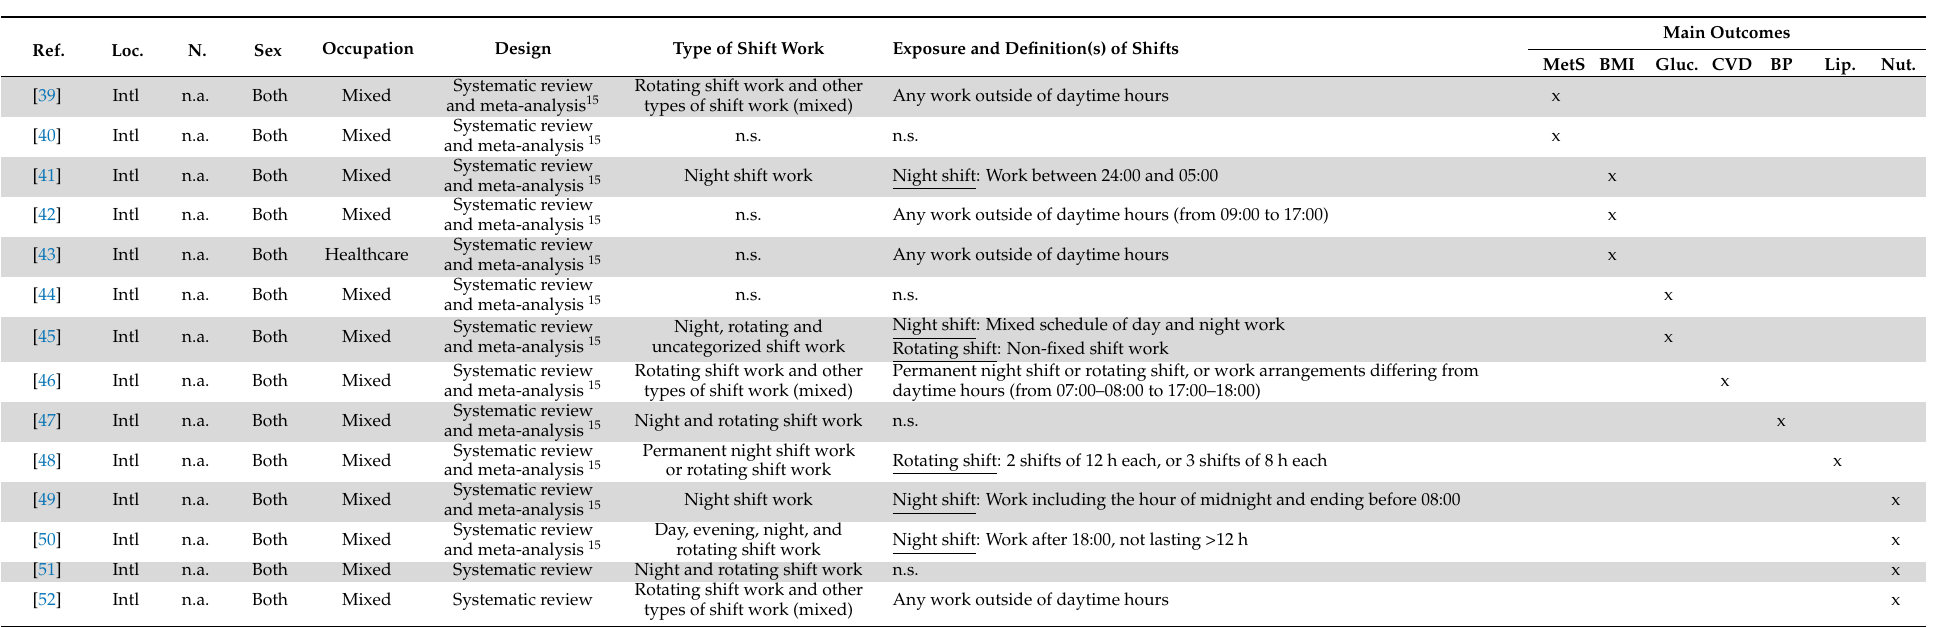
Rotating shift work and other types of shift work (mixed) Any work outside of daytime hours